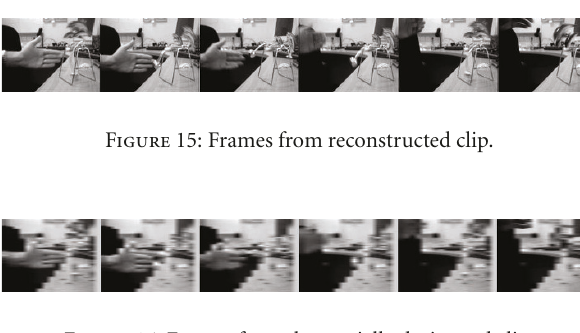
Figure 16: Frames from the spatially decimated clip.